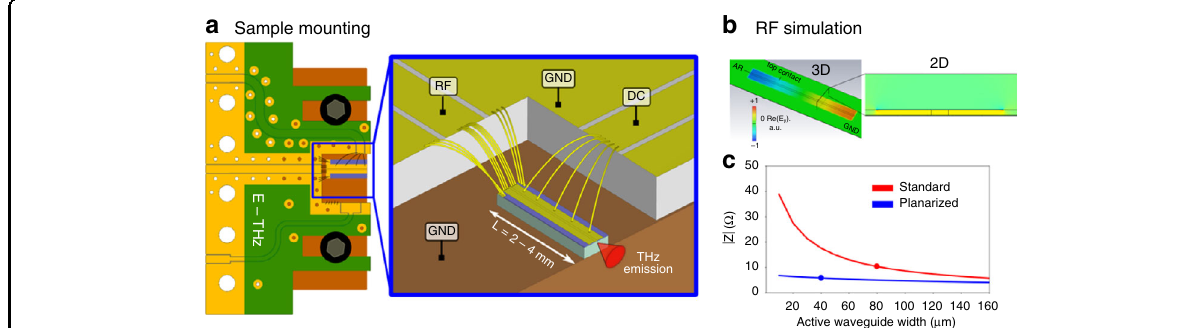
Fig. 3 Optimized sample mounting and simulated RF properties of planarized waveguides. a Illustration of the sample mounting with a custom RF-optimized PCB. Several short signal wires are connected from a 50 Ω matched coplanar waveguide to one end of the waveguide, with short ground wires for minimal RF injection and readout losses (inset, top left). The DC laser bias is provided through a separate contact pad (inset, top right). b 2D and 3D eigenmode numerical simulations of the RF fi eld at 20 GHz show that the whole extended top metallization encompasses a cavity with the ground plane. c Computed impedance from 2D COMSOL simulations for a frequency of 20 GHz and a varying active waveguide width. Typical waveguide widths are marked with